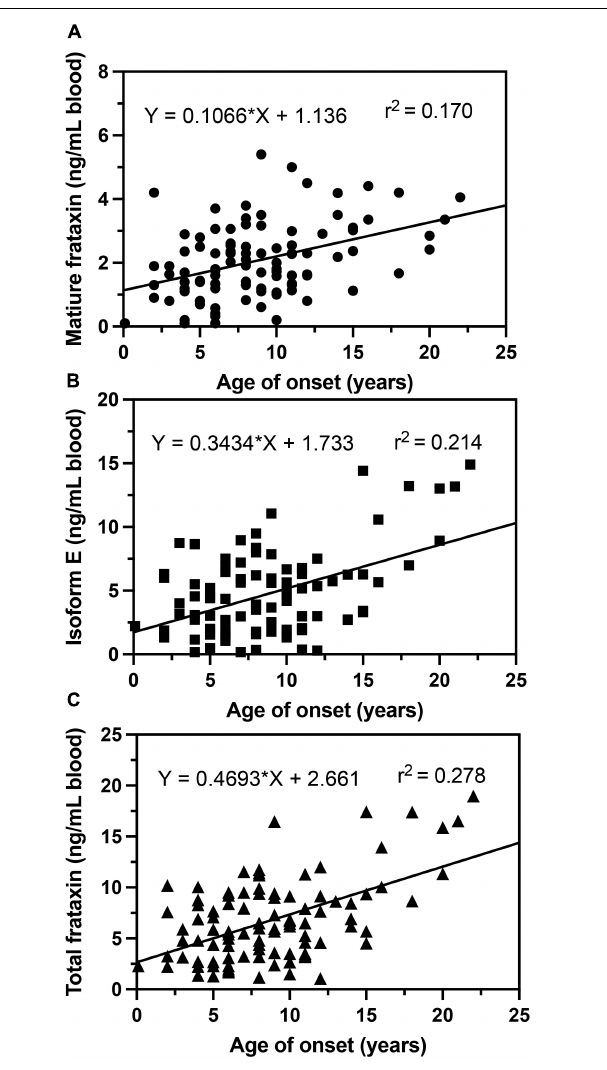
FIGURE 7 | Correlations of age of onset with whole blood frataxin levels. (A) Mature frataxin ( p < 0.0001). (B) Isoform E ( p < 0.0001). (C) Total frataxin ( p <